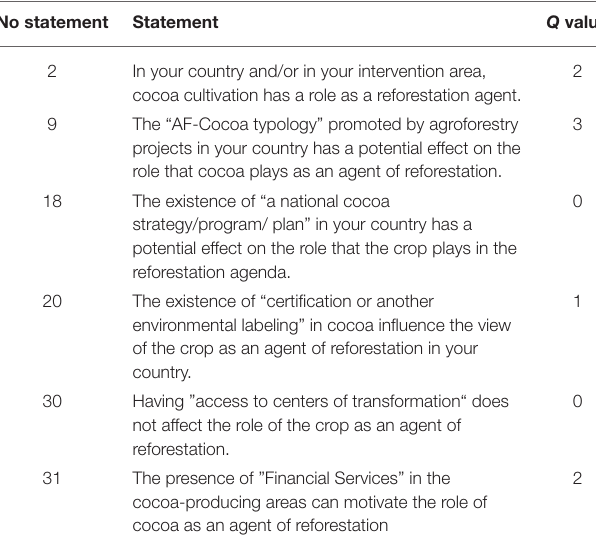
TABLE 3 | Consensus statements* from the discourses of Nicaraguan interviewed cocoa